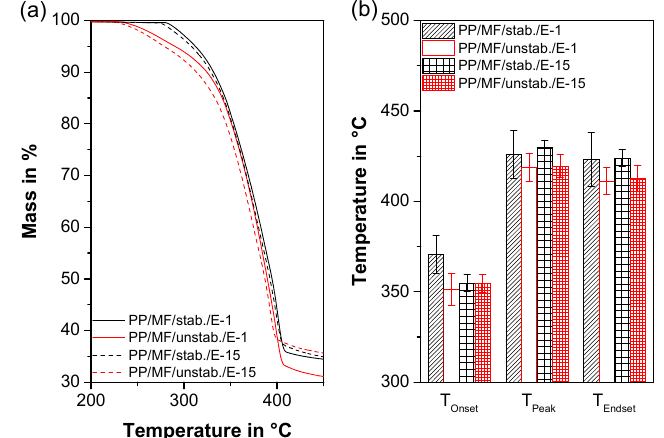
Figure 8. Mean mass as a function of temperature ( a ) and a detailed comparison of the onset ( T Onset ), peak ( T Peak ), and end-set temperature ( T Endset ) for both composites, each extruded once and 15 times ( b ).